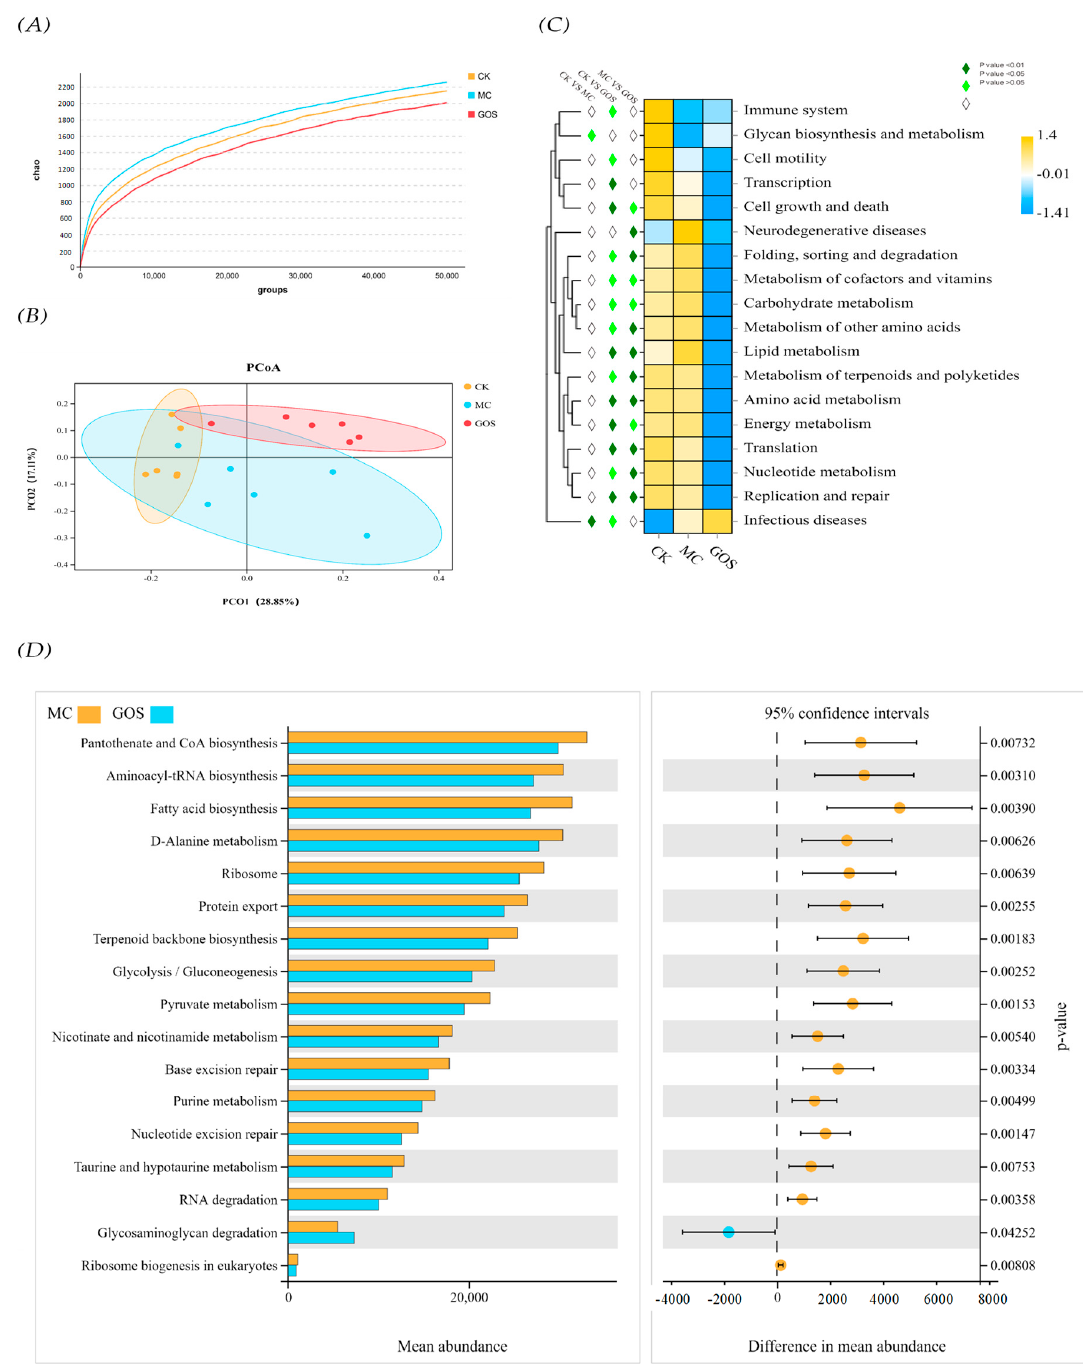
Figure8. Thediversityandfunctionpredictionofintestinalfloraindi ff erentgroupsofmice. ( A )Dilution curve; ( B ) Principal Co-ordinate Analysis (PCoA) based on operational taxonomic units (out) results; ( C ) Heat map of function prediction; ( D ) Mean abundance of di ff erential